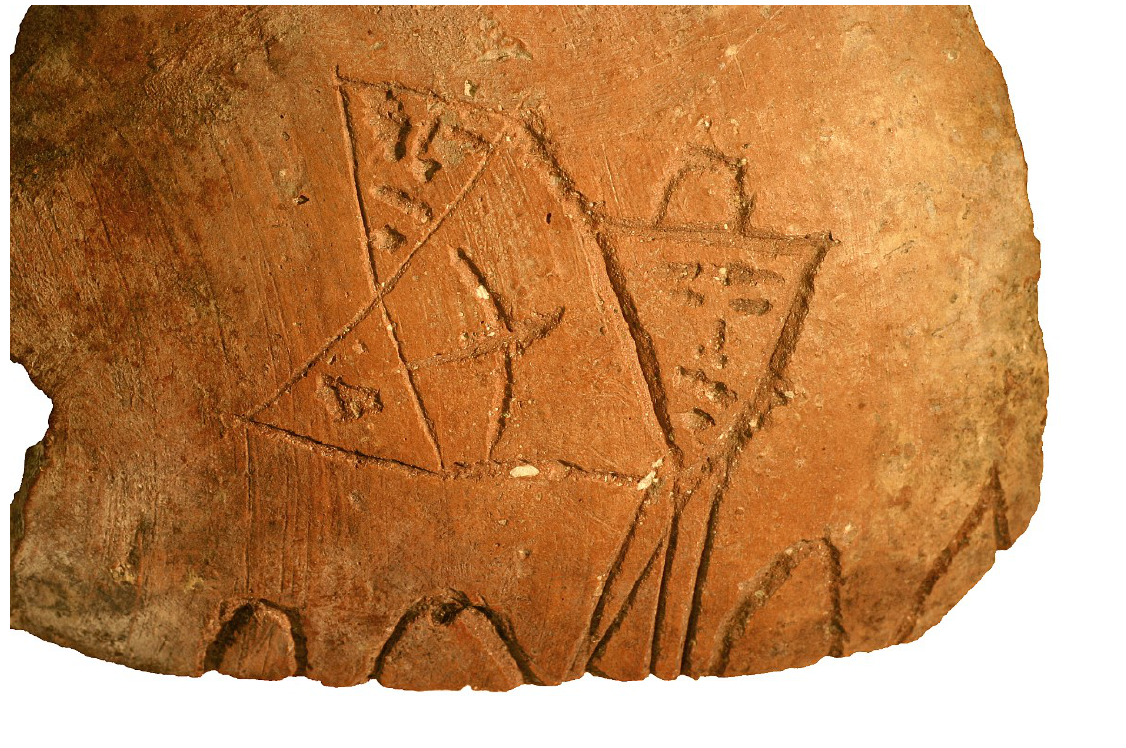
Figure 9 Pictorial design on a sherd of a strainer (Jerusalem, Iron Age